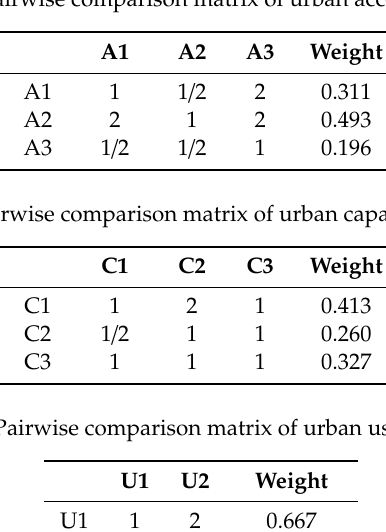
Table A3. Pairwise comparison matrix of urban access indicators.